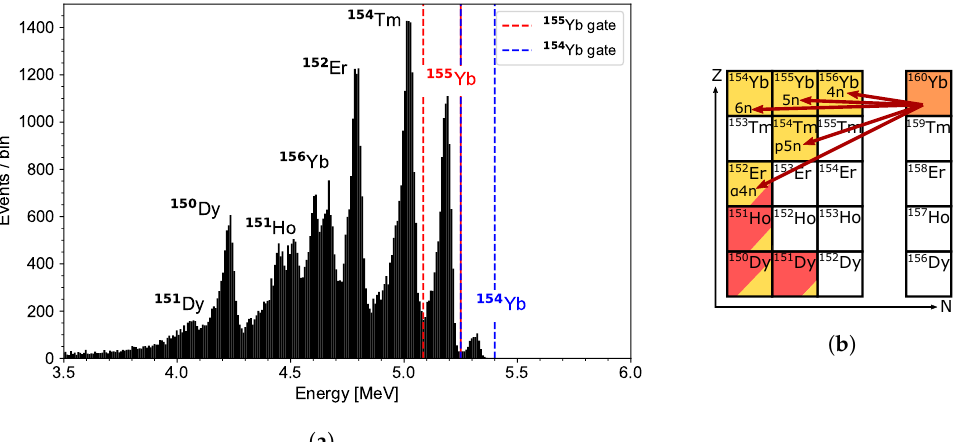
Figure 3. ( a ) Alpha spectrum of indirectly and directly produced nuclei in the 48 Ca+ 112 Sn fusion- evaporation reaction guided directly onto the PIPS detector after stopping inside of the gas cell. The signal strengths mostly reflect the respective production cross sections. Additionally, decay losses during ion transport through the gas cell impact the signal strength especially of the short-lived 154 Yb. Data for this spectrum were collected for 50min with parasitic beam of 5ms long beam pulses with a repetition rate of 5Hz from the UNILAC accelerator at the GSI. ( b ) Observed evaporation channels of the 48 Ca+ 112 Sn fusion-evaporation reaction for a beam energy of 4.55MeVu − 1 . Shown are products and the subsequent daughter nuclides decaying via alpha decay which are mainly observed in the